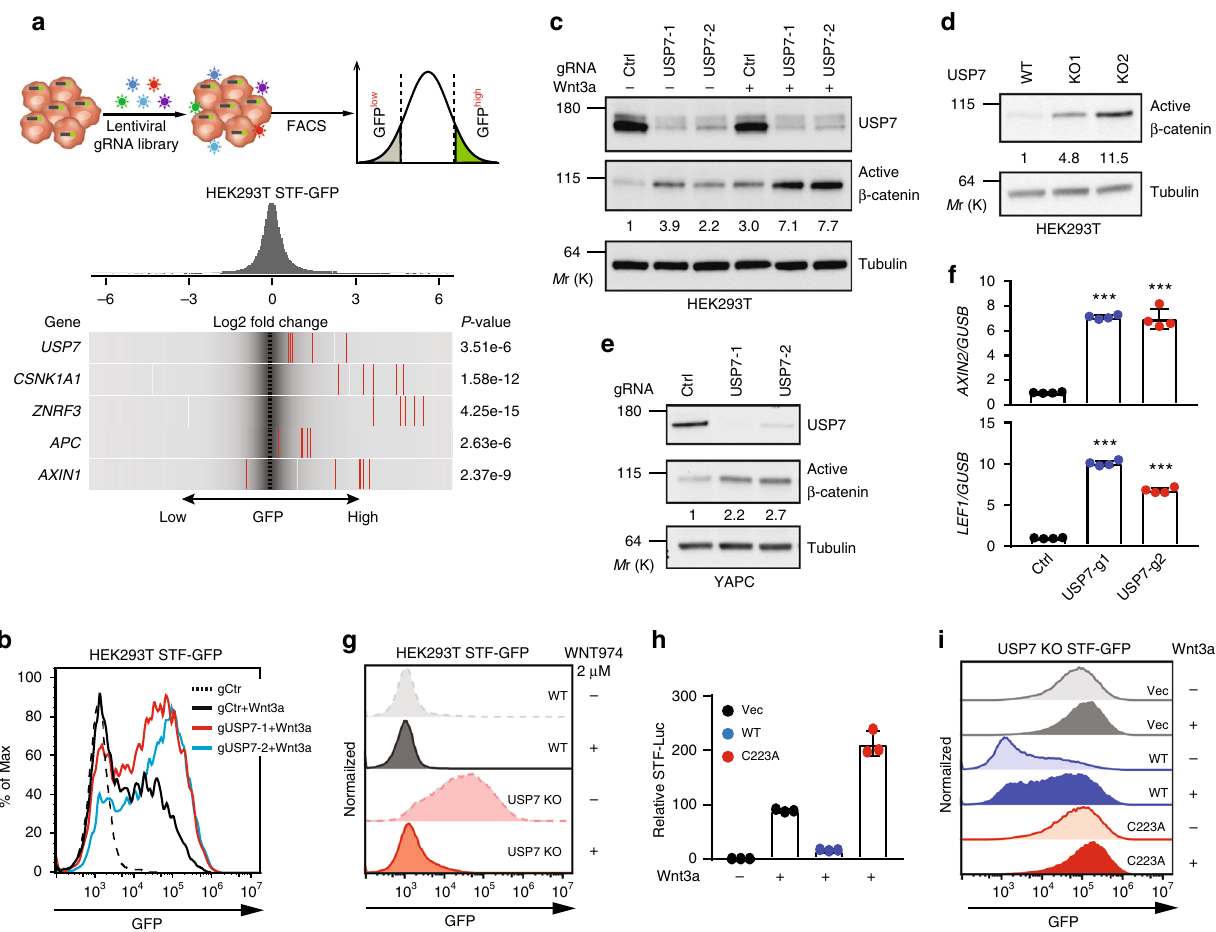
Fig. 1 USP7 is a potent negative regulator of Wnt/ β -catenin signaling. a Top panel, infographic description of pooled CRISPR screen. Bottom panel, frequency histograms of gRNAs identi fi ed in the high GFP population of HEK293T pooled CRISPR screen. The RSA P -value is shown along with the log2 fold change of the fi ve gRNAs per gene for the indicated set of genes. gRNAs targeting indicated genes are shown by the red lines. b Knockout of USP7 by independent gRNAs enhances Wnt3a-induced STF-GFP in FACS assay. STF-GFP reporter was induced by 10% Wnt3a conditioned medium (Wnt3a CM) overnight. The FACS data is a representative from three independent experiments. c Knockout of USP7 in HEK293T cells enhances Wnt3a-induced accumulation of active β -catenin. Cells were treated with control medium or 10% Wnt3a CM overnight. The intensity of active β -catenin and Tubulin bands was quanti fi ed by ImageJ, and quanti fi cation of normalized active β -catenin band intensity is shown. d HEK293T USP7 knockout clones express higher levels of active β -catenin as compared to wild-type cells in the absence of exogenous Wnt. e , f Knockout of USP7 in YAPC cells increases the protein level of active β -catenin ( e ) and mRNA level of β -catenin target genes. Error bars denote the SD between four replicates; one-way ANOVA was used to determine the statistical signi fi cance; *** p value ≤ 0.001 ( f ). g Porcupine inhibitor (WNT974) blocks the high expression of STF-GFP in HEK293T